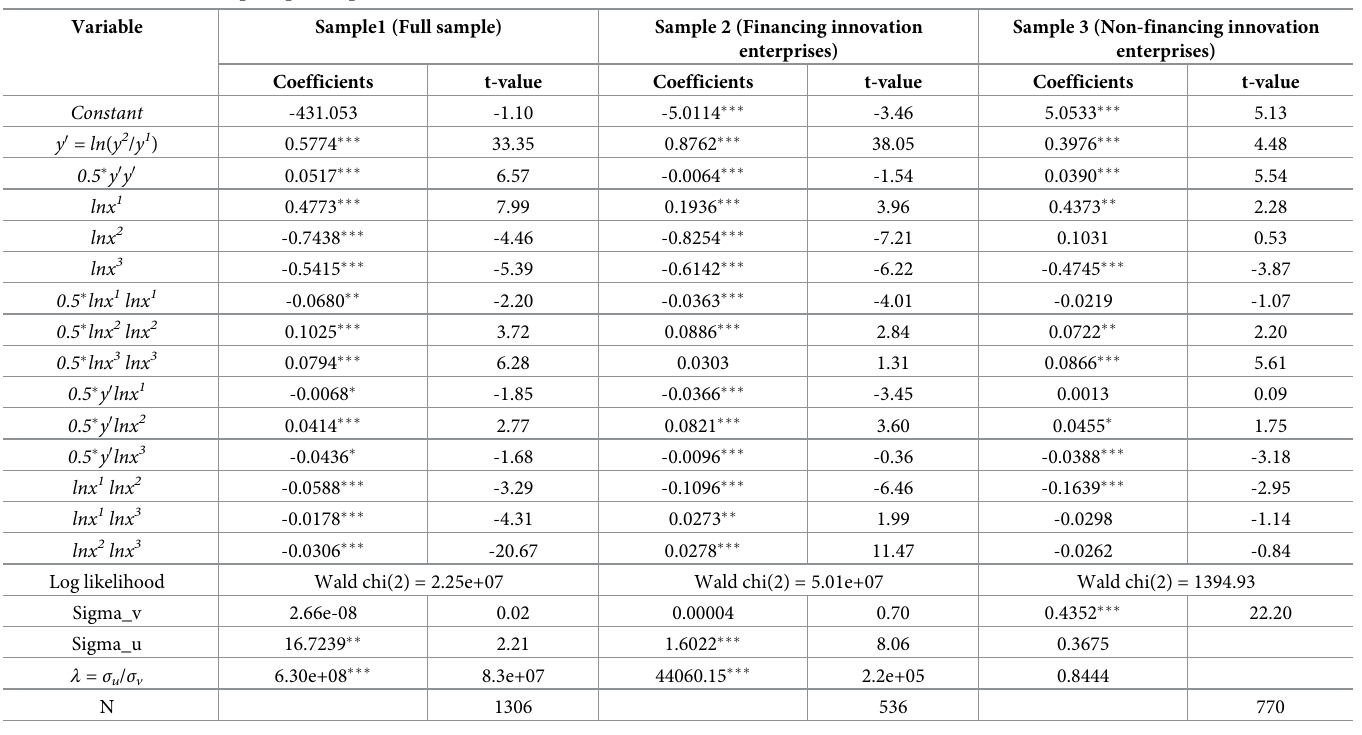
Table 3. Results of the multiple input-output SFA method.